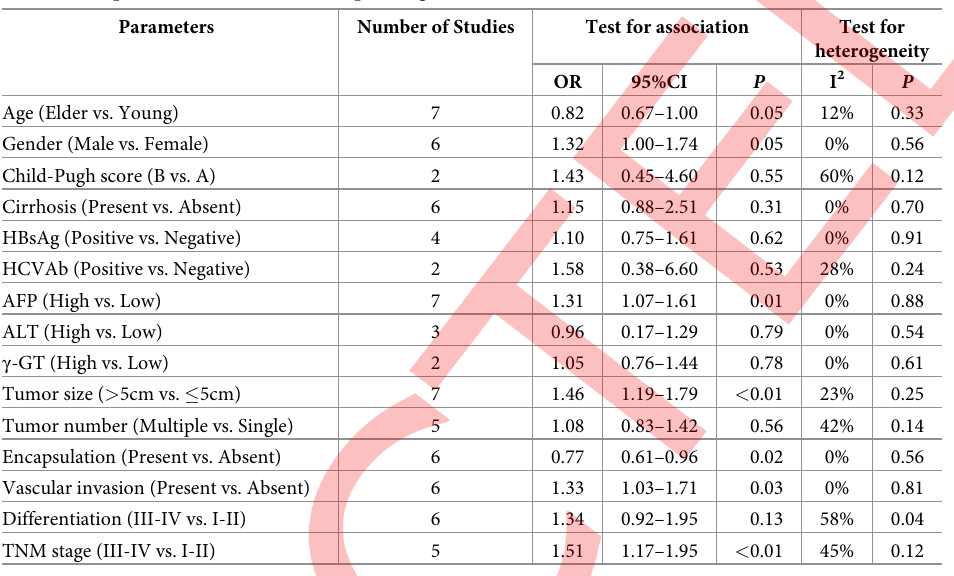
Table 4. The pooled associations of clinicopathologic characteristics with intratumoral CD68+